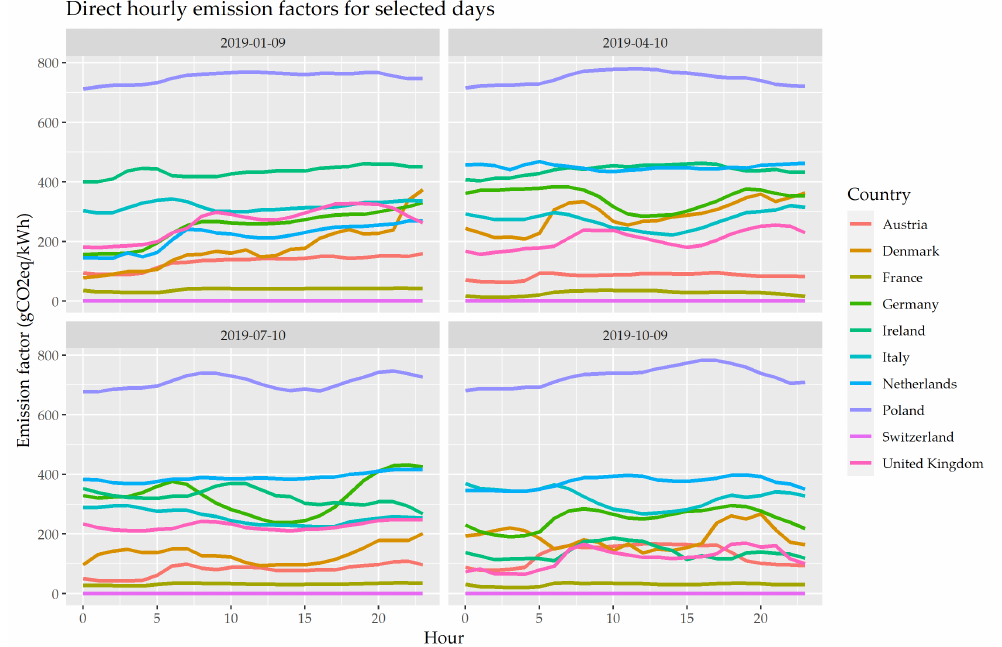
Figure 4. Comparison of direct hourly emission factors for selected days (the second Wednesday of different months in